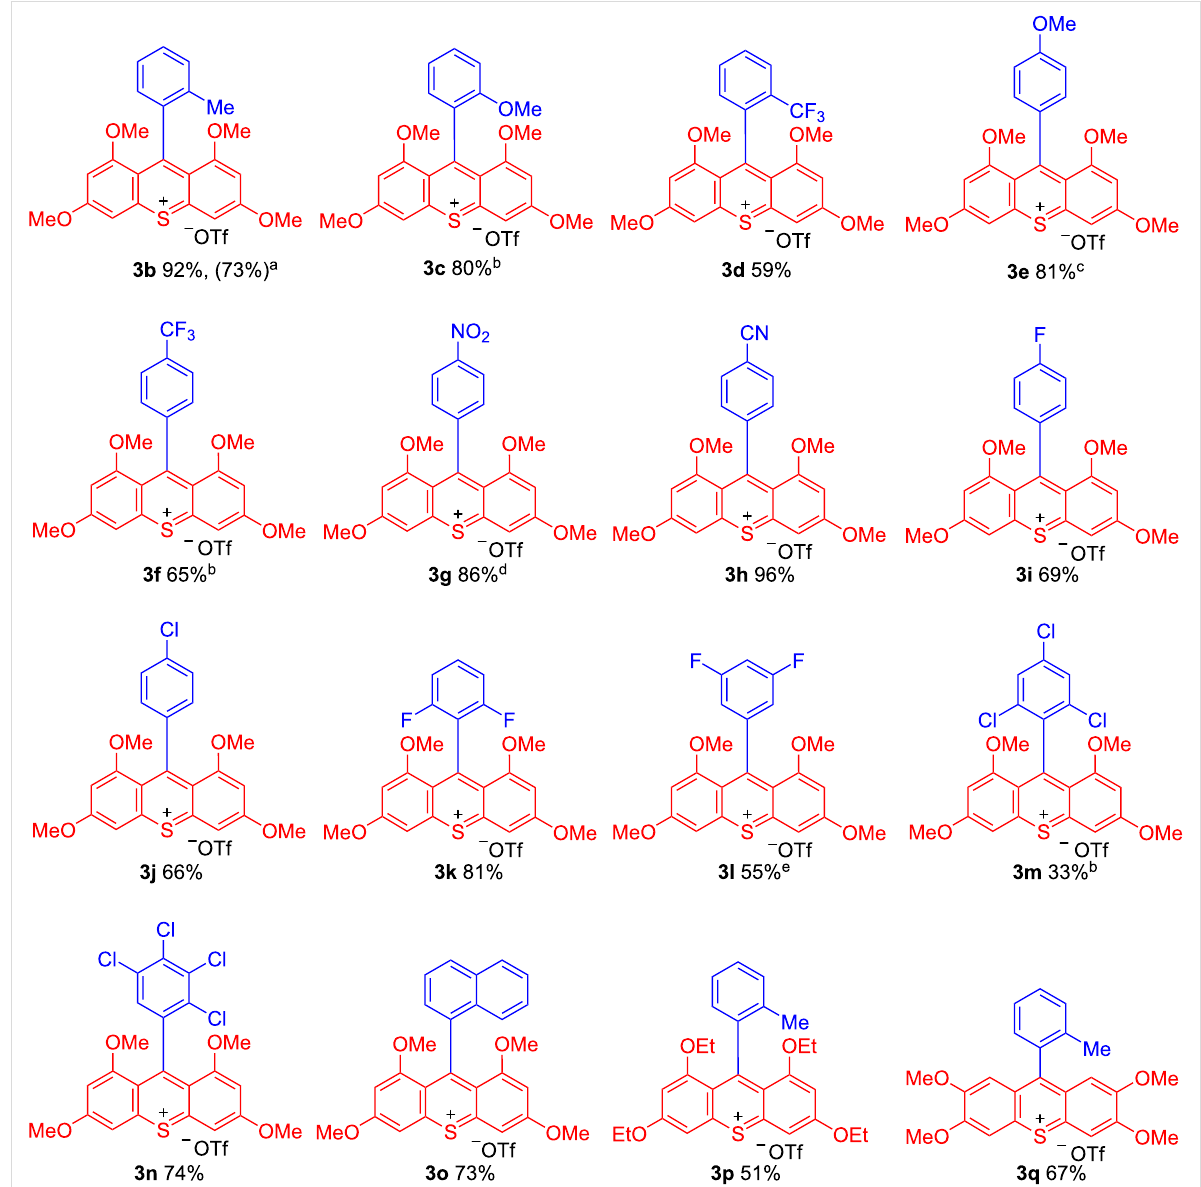
Figure 1: The generality of diaryl sulfide 1 and benzoyl chloride 2 . a The reaction was carried out with 1a (2.0 mmol), 2a (6.0 mmol), TfOH (3.0 equiv) in chlorobenzene (40.0 mL) at reflux for 1 h under N 2 . b 2 (2.0 equiv) and TfOH (2.0 equiv) were used at 120 °C. c 2 (2.0 equiv) and TfOH (2.0 equiv) were used. d 20 h. e 2